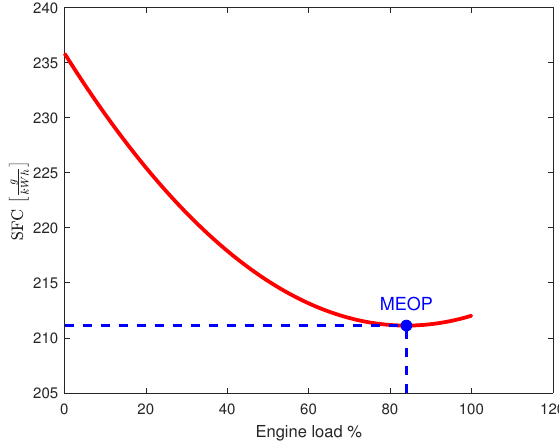
Figure 6. Specific fuel consumption of the